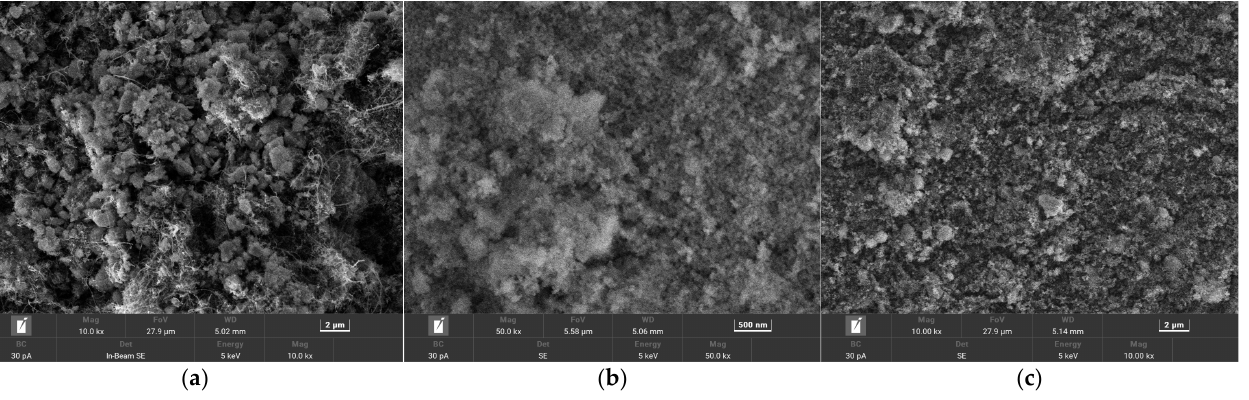
affects the diffraction intensities.